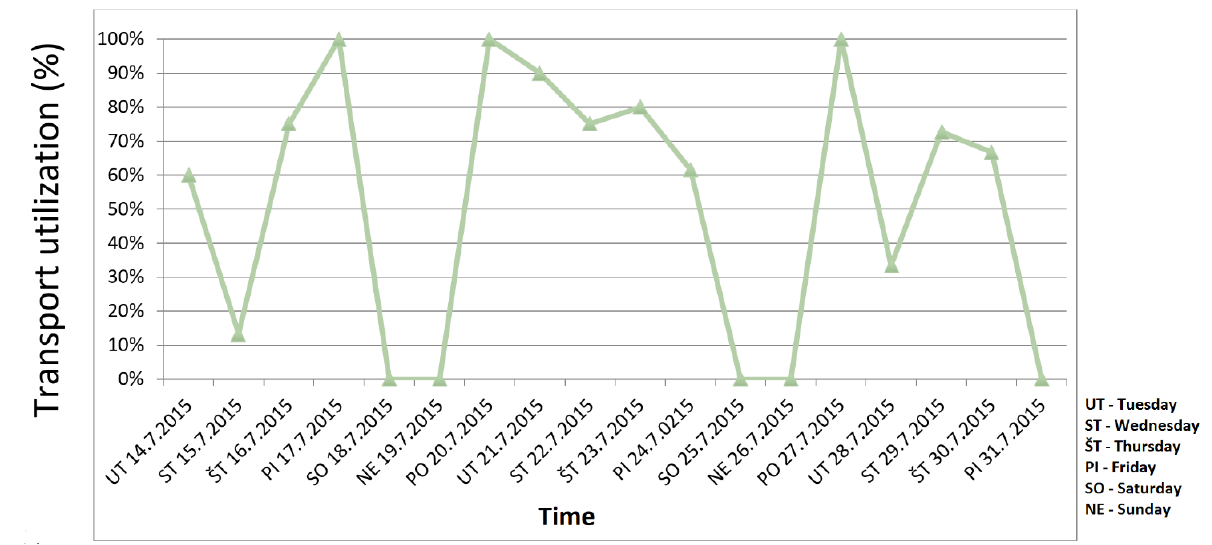
Figure 10: Transport performance of AGV